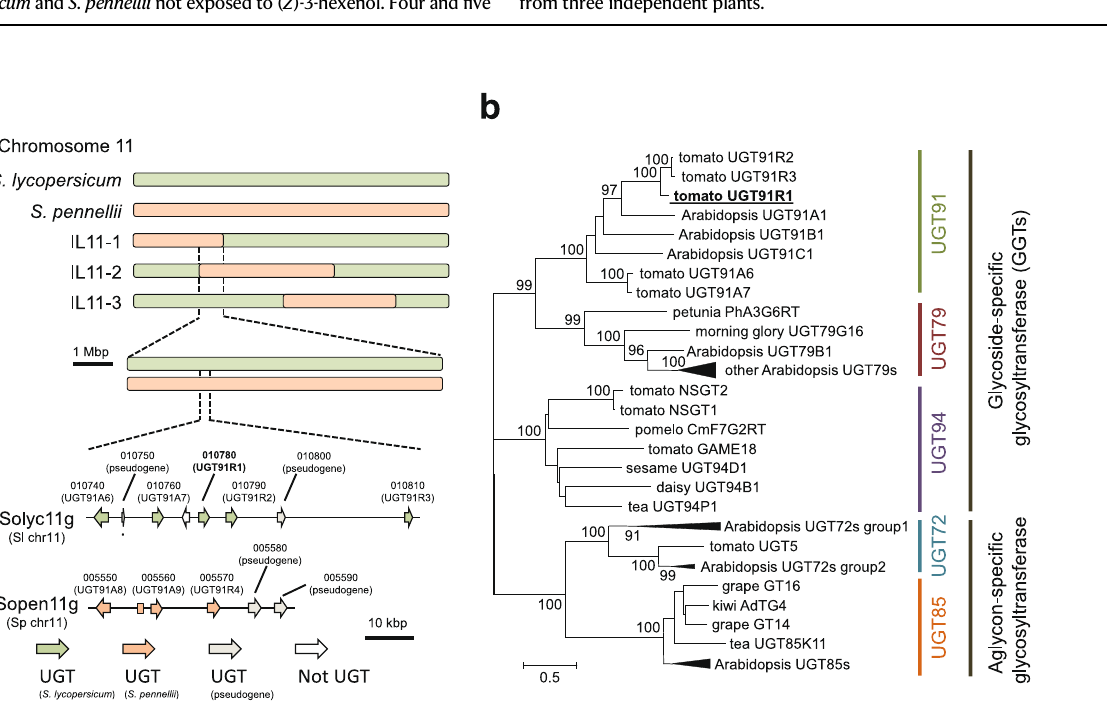
Fig. 1 | Chemical pro fi les of ( Z )-3-hexenyl β -vicianoside (HexVic) in introgres- sion lines of S. pennellii . a ( Z )-3-Hexenyl β -vicianoside (HexVic) content in the leaves of parental species ( S. lycopersicum cv. M82 and S. pennellii (LA0716)) of introgression lines (ILs)exposed (+)ornotexposed ( − ) to ( Z )-3-hexenol.Error bars indicate standard error of the mean from independent experiments (nine plants each of S. lycopersicum and S. pennellii not exposed to ( Z )-3-hexenol. Four and fi ve